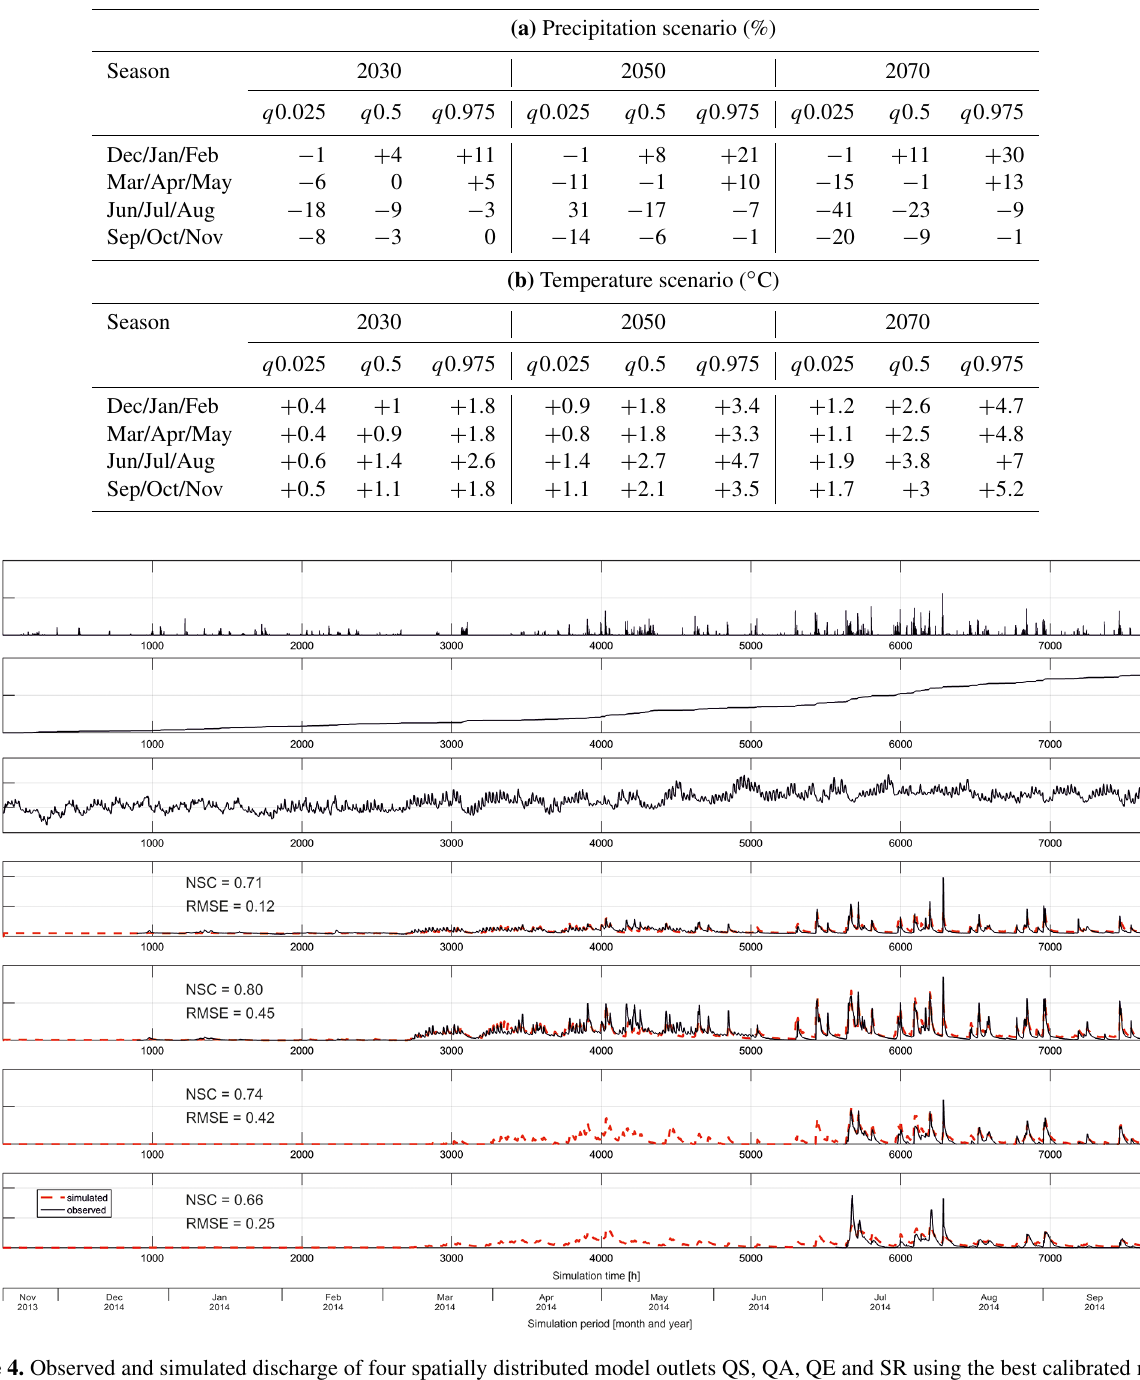
Table 1. (a) The median ( q 0 . 5) and the confidence intervals ( q 0 . 025 and q 0 . 975) of the probabilistic precipitation scenarios for years 2030, 2050 and 2070 are explicitly given as percentage change (compared to 1990) and applied for the analysis described in Sect. 3.6. The scenarios are based on Frei (2004). (b) The median ( q 0 . 5) and the confidence intervals ( q 0 . 025 and q 0 . 975) of the probabilistic temperature scenarios for years 2030, 2050 and 2070 are explicitly given as absolute change (compared to 1990) and applied for the analysis described in Sect. 3.6. The scenarios are based on Frei (2004).